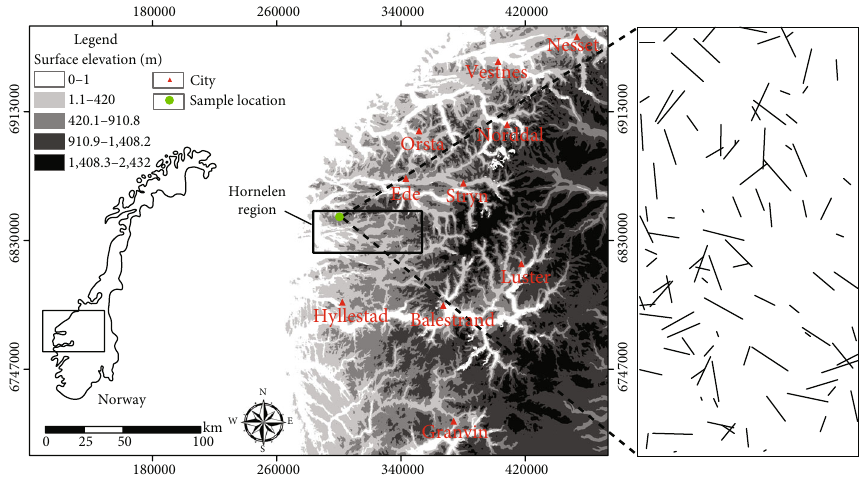
Figure 1: Outcrop map of the natural fracture system in the sandstone at Hornelen Basin, western Norway [5 –